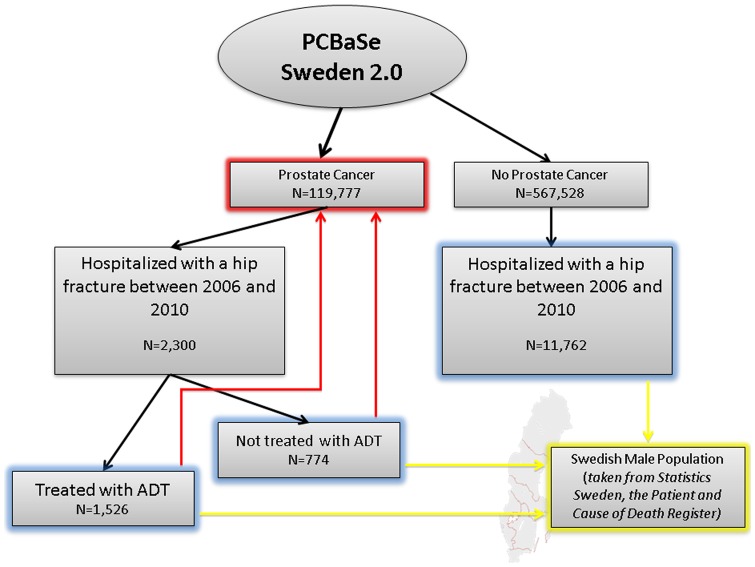
Selection of study cohort from PCBaSe 2.0.The effect of hip fracture on mortality is studied in three groups (blue boxes): men free of PCa, PCa men not on ADT, and PCa men on ADT. The effects are quantified using standardized mortality rates (SMRs) so that all three groups (blue boxes) are compared to the Swedish male population (yellow arrows). To take into account the effect of PCa on mortality, the two PCa groups are also compared to all men diagnosed with PCa, as registered in PCBaSe (red arrows).